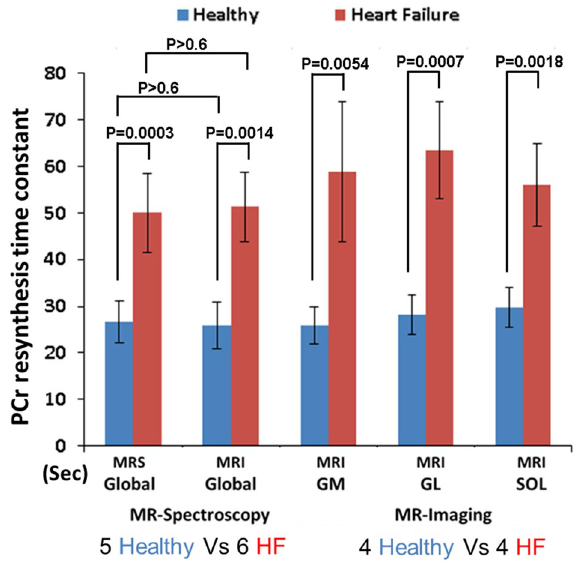
Figure 5. Comparison of results between cohorts. The PCr resynthesis time constant (mean ± SD) between healthy volunteers and HF-patients of Global ( 31 P-MRS and MRI) as well as regional ( 31 P-MRI) in